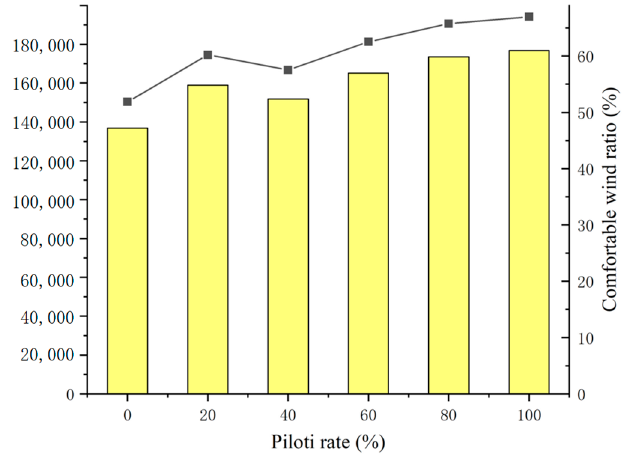
Figure 21. The changing pattern of a comfortable wind ratio under different piloti rates (Enclosed